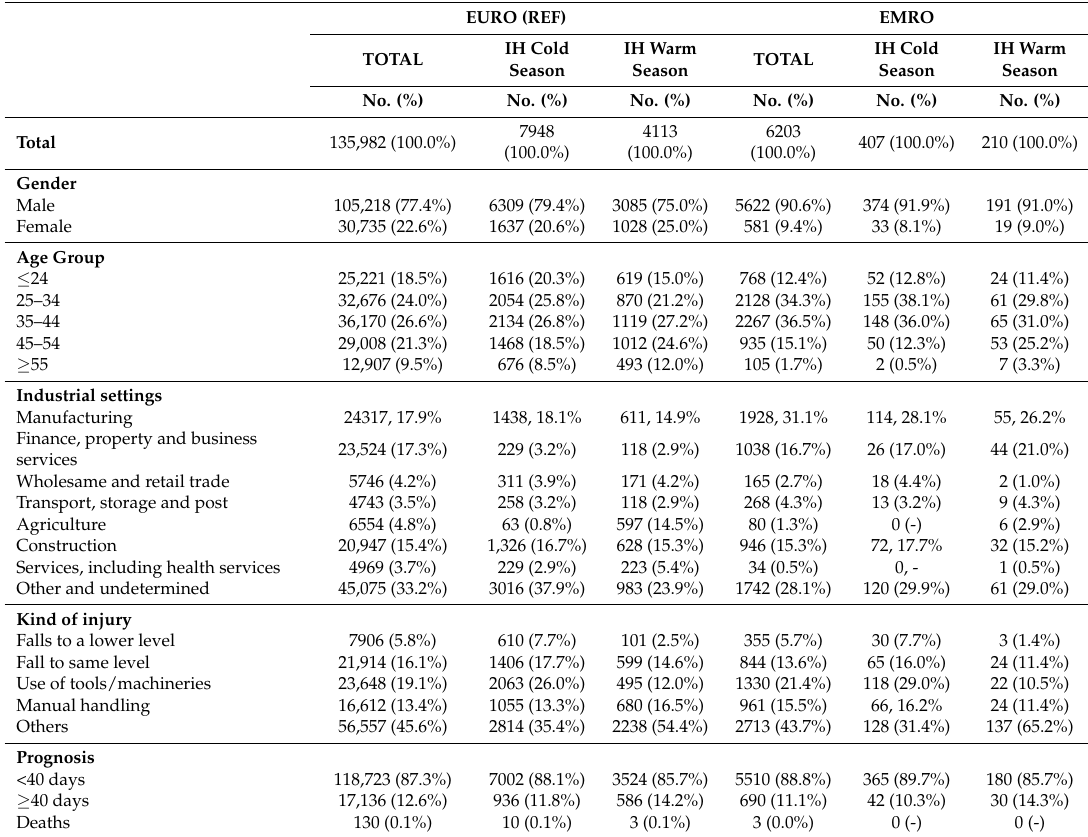
Table 2. Numbers of occupational injuries (OIs) that occurred in the Autonomous Province of Trento (APT) between 2000 and 2013, by WHO region of origin (EURO vs. EMRO) and by time period, comparing injuries occurring in the Islamic holiday time-period (IH), as a whole and dichotomized in cold season IH (mid September–mid June), and warm season IH (mid June–mid